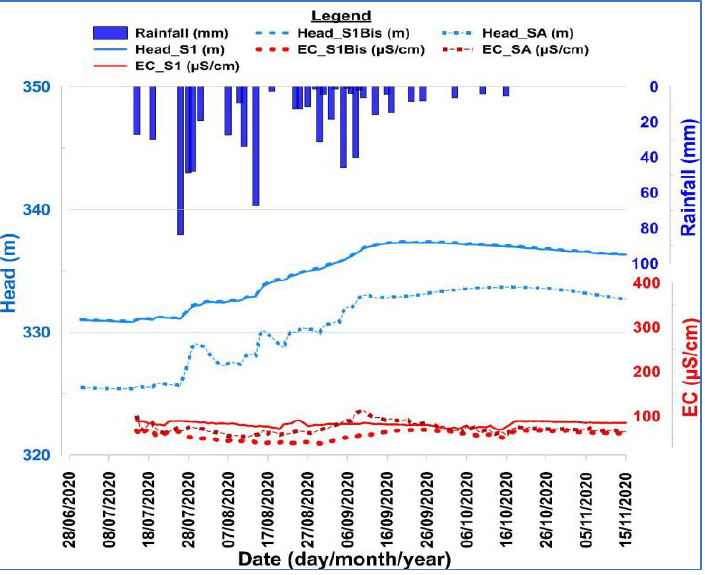
Figure 14. Groundwater hydrographs versus electrical conductivity in relation to rainfall at the central valley and toward the outlet.